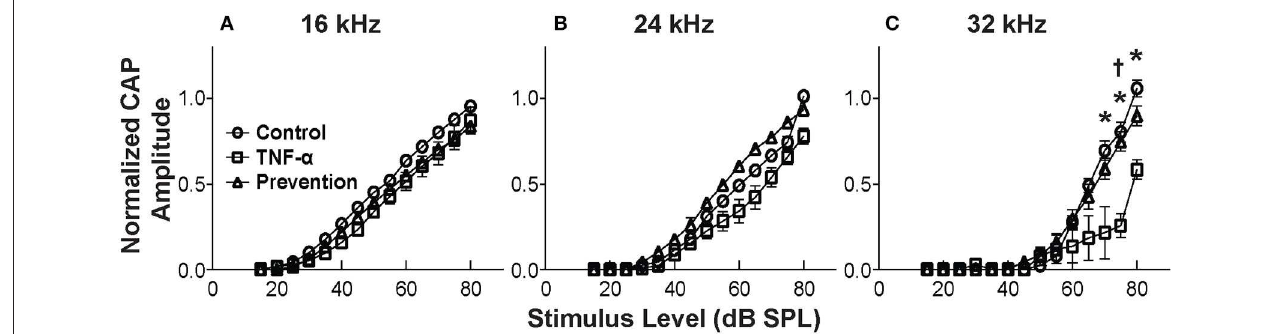
FIGURE 3 | Mean CAP amplitude vs. level functions for 16kHz (A) , 24kHz (B), and 32kHz (C) for the control group (perfused with artificial perilymph), the TNF- α group and the prevention group (animals received etanercept 2h prior to receiving TNF- α ). Amplitudes are normalized to the 80 dB SPL pre-intracochlear perfusion response for each animal. Normalized amplitudes in TNF- α group are significantly decreased relative to control and prevention group at 32kHz. *, † = statistically significant at p < 0.05 for control vs. TNF- α and TNF- α vs. prevention groups, respectively. Error bars represent SEM. Figure legend in (A) also applies to (B,C) .